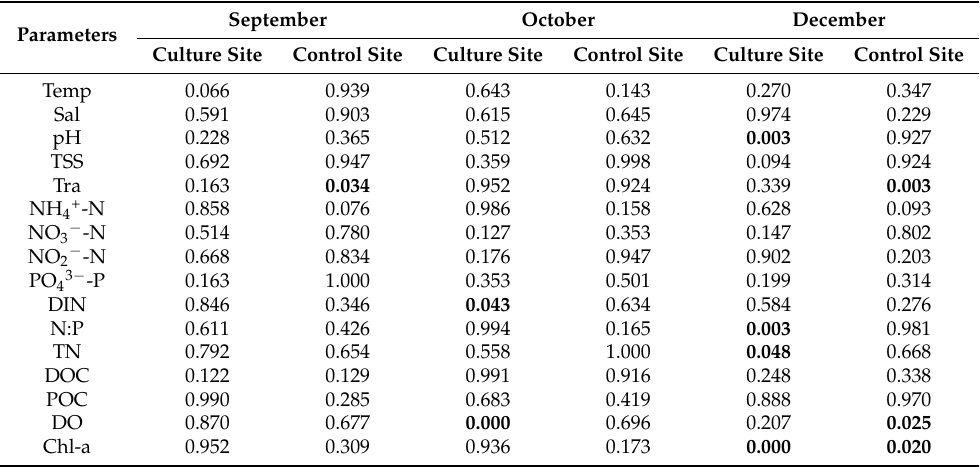
Table 4. Significant variations between culture and reference sites as well as control and reference sites on a monthly scale in Taoluo zone. Numbers in bold indicate significant differences. The abbreviations are the same in Table